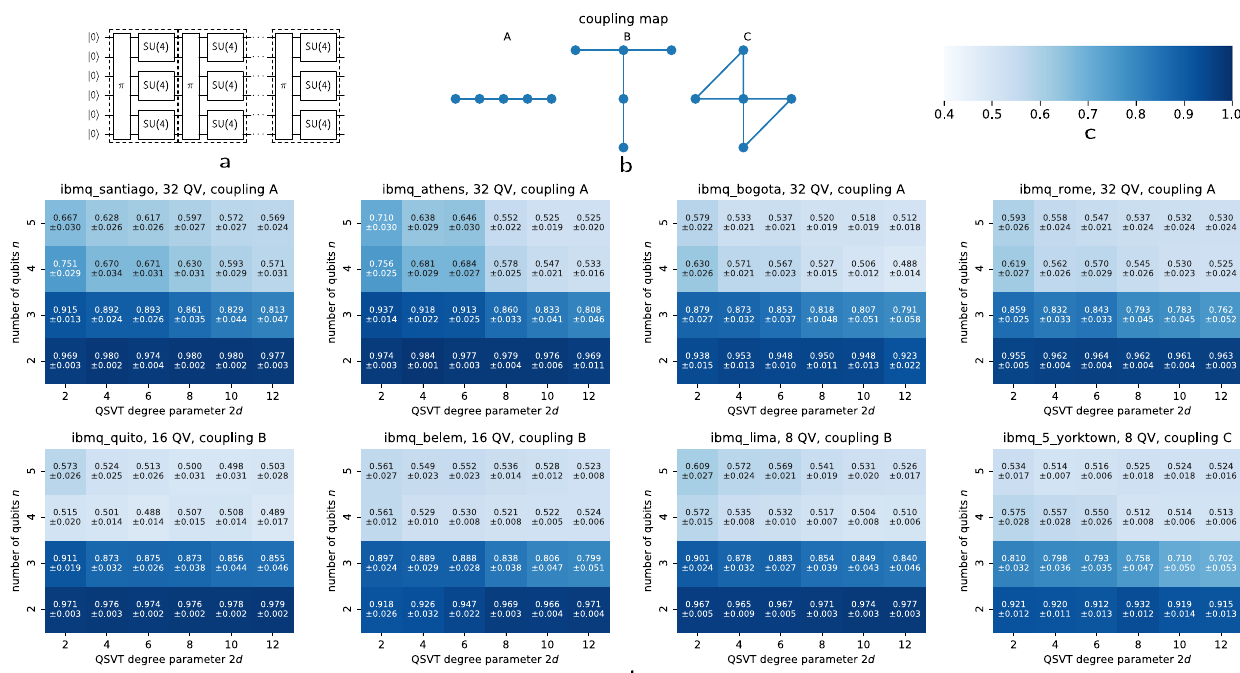
Fig. 2 Quantum unitary evolution score (QUES) of the 5-qubit quantum devices provided by the IBM Q platform. ( a ) Visualization of the quantum circuit U A used in computing QUES. When the number of qubits is n , there are n layers of the dashed boxes consists of the random permutation of the qubits labels followed by random two-qubit gates. After calling the transpiler, the circuit U A is decomposed with respect to ffiffiffi p ; X ; CNOT g and the coupling map which indicates the available qubit pairs on which CNOT can act. b Layouts of X the basic gate set Γ ¼ f Rz ; coupling maps. c Color bar of the heatmap. d Each heatmap displays the benchmarking result of a speci fi c quantum device, with the title showing the name of the device, its quantum volume, and its coupling map. Each QUES is estimated from 50 circuit instances. Each circuit instance is measured with 1000 measurement shots. The number displayed in each heatmap is the QUES value and its 95% con fi dence